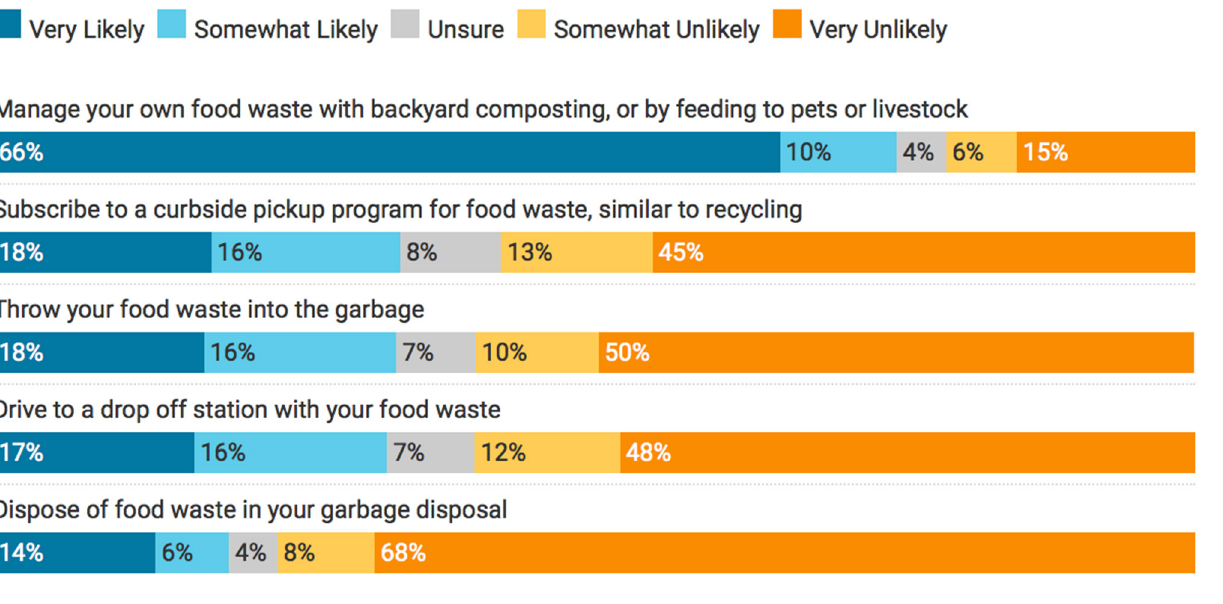
FIGURE 3 | Likely future food waste strategies to comply with Act